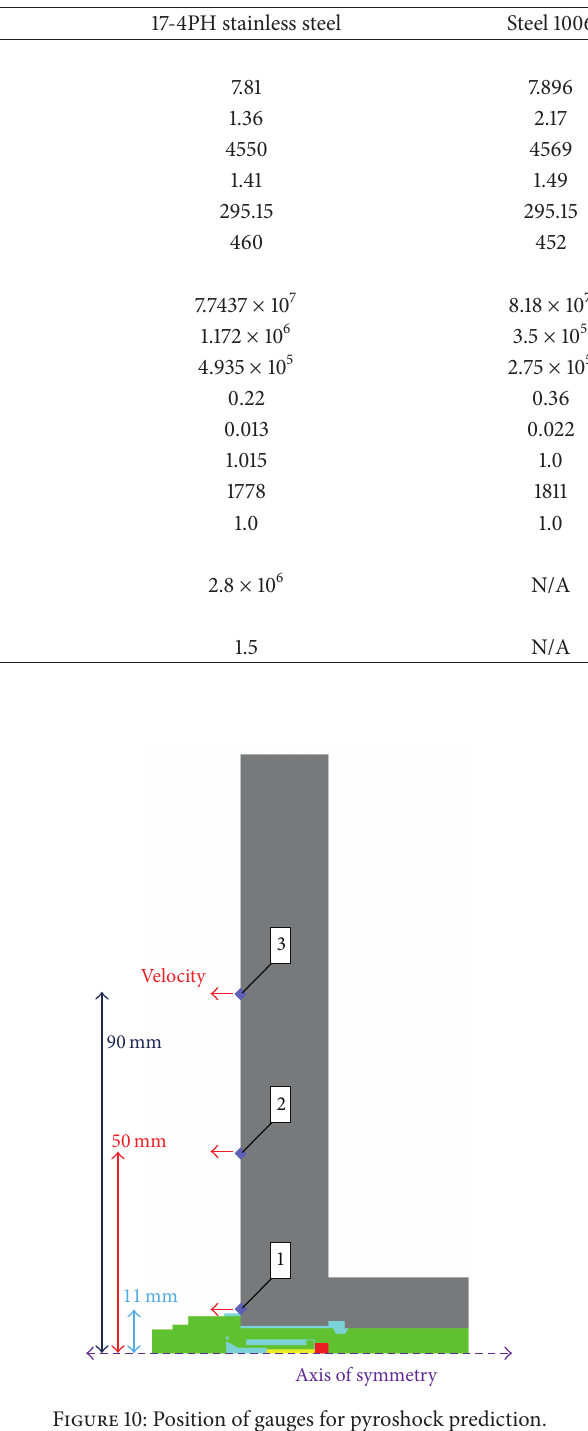
measurement point up to 1 ms. In maximax SRS, the